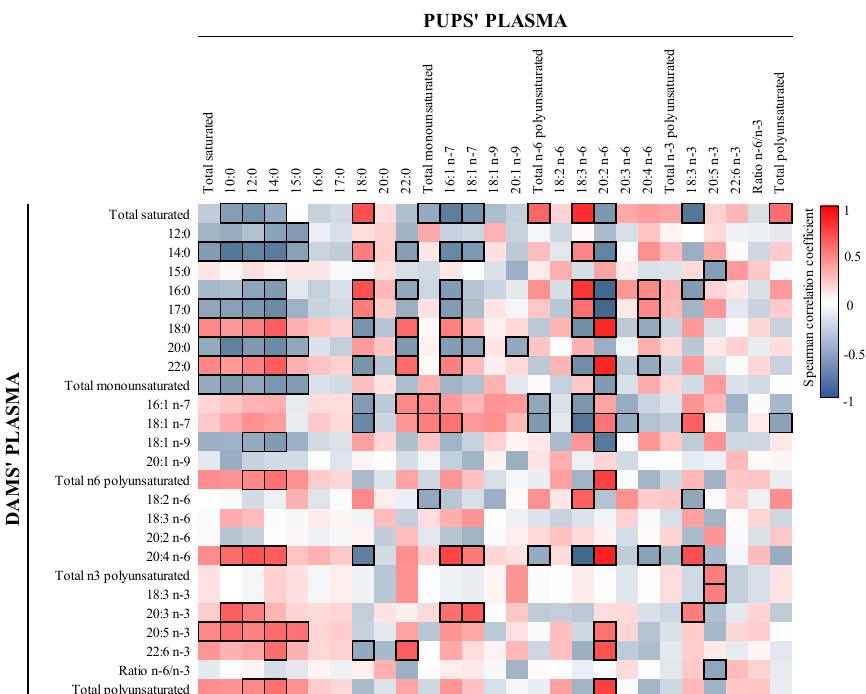
Figure 2. Correlations between dams’ and pups’ FA plasma content. The Spearman correlation coefficient is represented in the heat map following the color in the legends. Correlations with statistical significance ( p < 0.05) are shown in a bold frame. Results derived from n = 6 for milk and dams’ plasma and n = 24 for pups’ plasma.